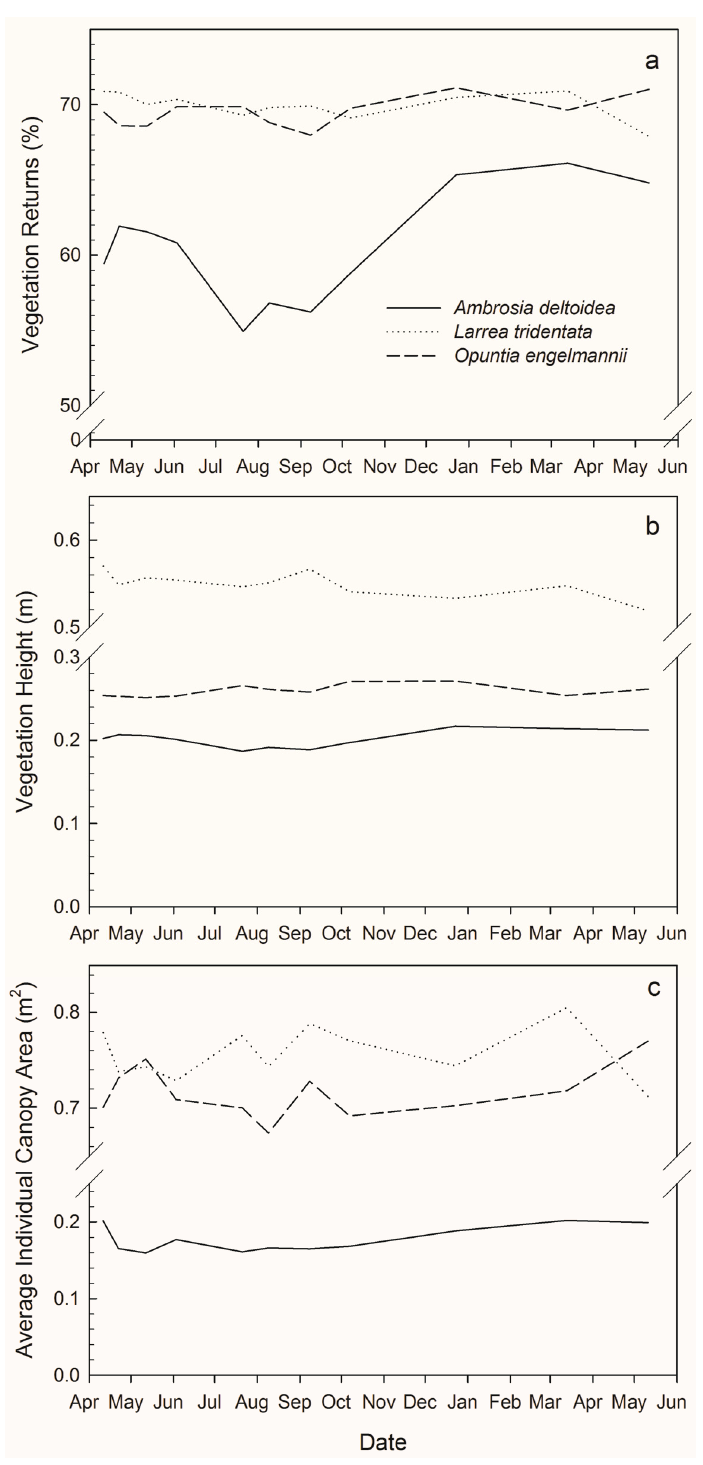
Figure 5. Time series of ( a ) percentage of LiDAR returns classified as vegetation; ( b ) vegetation height; ( c ) canopy area, for individual plant canopies aggregated by species for the three predominant species at the study